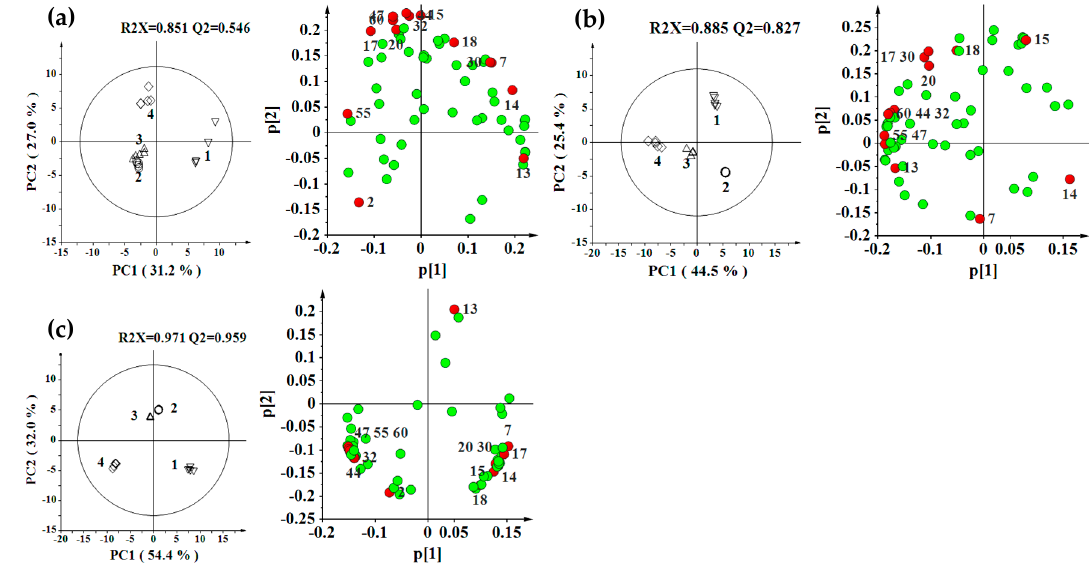
Figure 4. PCA scores plots and loading plots derived from LC-MS data for S. miltiorrhiza extracts from four different genotypes (1, Genotype 1; 2, Genotype 2; 3, Genotype 3; and 4, Genotype 4) for each location (( a ) Zhuyang; ( b ) Changqing; and ( c ) Taian). 14 red colored metabolites in loading plots were the genotype-specific metabolites which we obtained from OPLS-DA: 2, Procatechuic acid; 7, Salvianolic acid F; 13, Salvianolic acid I; 14, Salvianolic acid E; 15, Rosmarinic acid; 17, Lithospermic acid; 18, Prolithospermic acid derivative; 20, Salvianolic acid B; 30, 7 α -hydroxyallyl-royleanone; 32, Tanshinone IIB; 44, 15,16’-dihydrotanshinone I; 47, Methyltanshinonate; 55, 1,2’-dihydrotanshinone I; and 60, Tanshinone IIA.